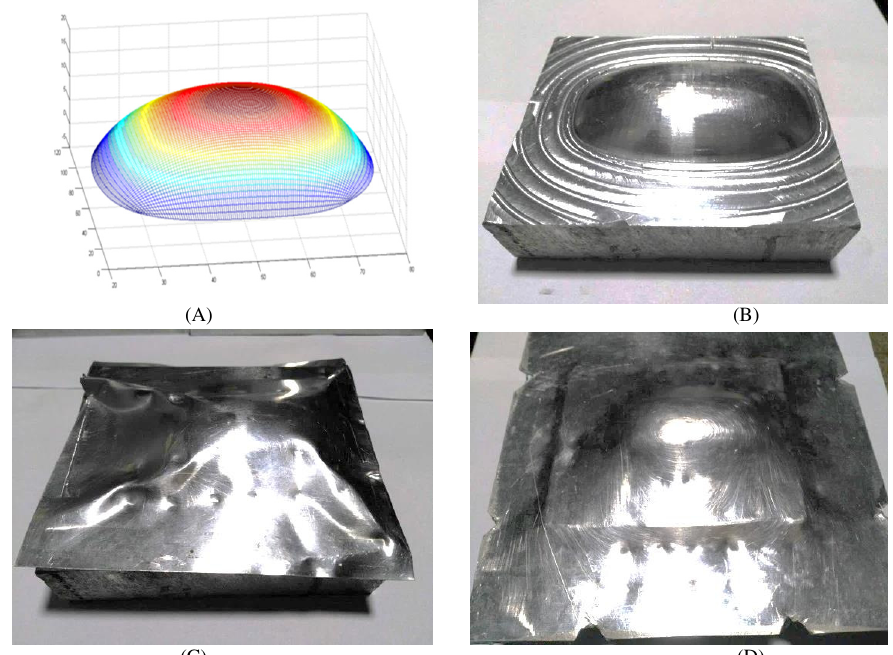
Fig. 9. CAD-design and the product manufacturing using multi-point forming die (A) CAD-design (B) forming die (C) final product without blank holder (D) final product using blank